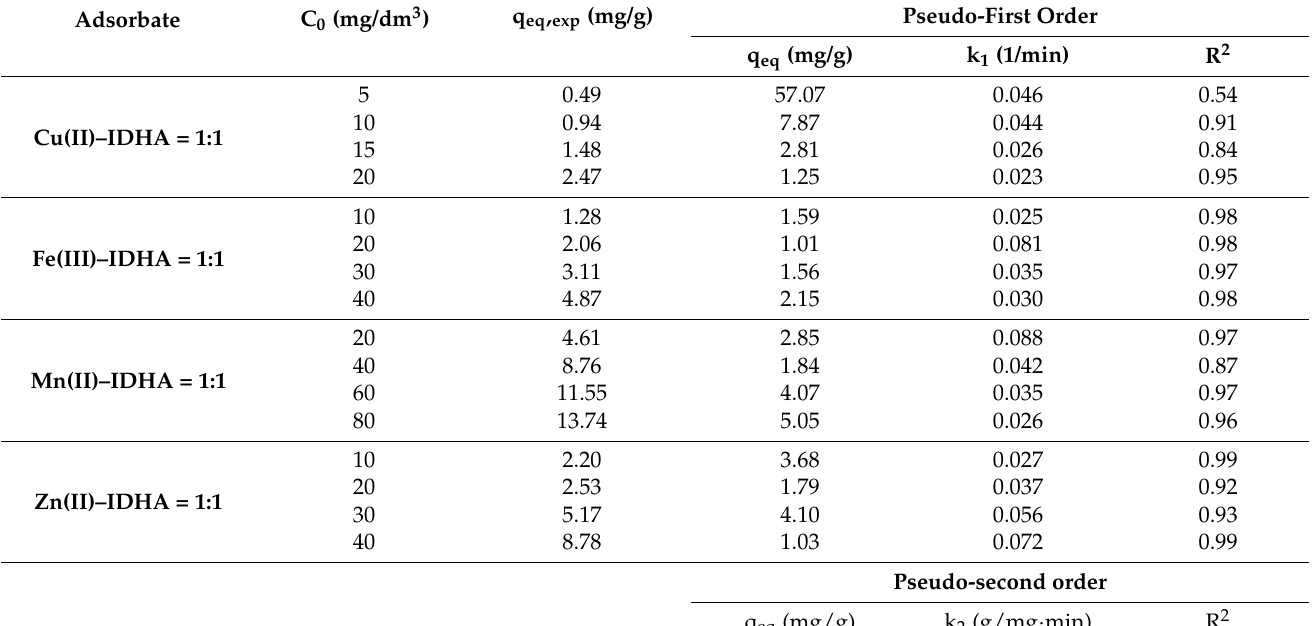
Table 4. Kinetic parameters for sorption of Cu(II), Fe(III), Mn(II), and Zn(II) complexes with IDHA onto NaP1CS.